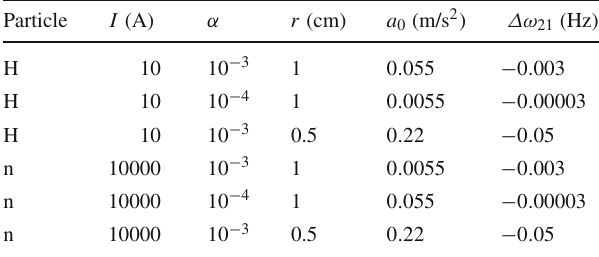
Table3 Extraaccelerationandthegravitationtransitionfrequencyshift in the magnetic field of a linear current due to the non-verticality of wire alignment ( ¯ h Δω 21 = Δ E 2 − Δ E 1 )